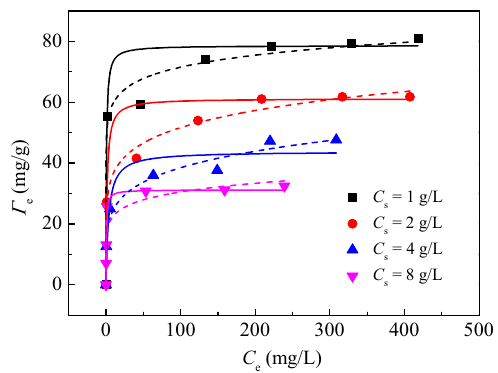
Figure 7: Sorption isotherms of Pb ( II ) on 50% B/LDHs at di ff erent = 0.010 M, 25°C, pH 6.0. The dots represent sorbent dosages. C NaNO 3 experimental data, the solid lines represent Langmuir model fi ts, and the dashed lines represent Freundlich model fi ts.